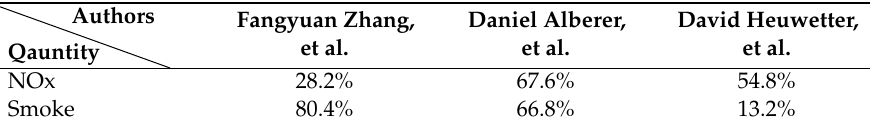
Table 3. Comparison of experimental results by different authors.